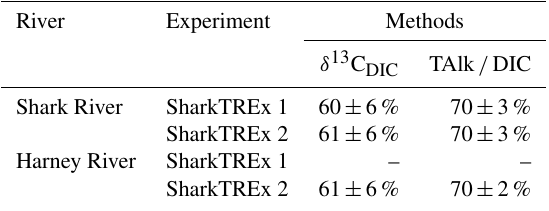
Table 3. Mangrove contribution to P [ DIC ] estuary determined from δ 13 C DIC mass balance and TAlk / DIC ratios.